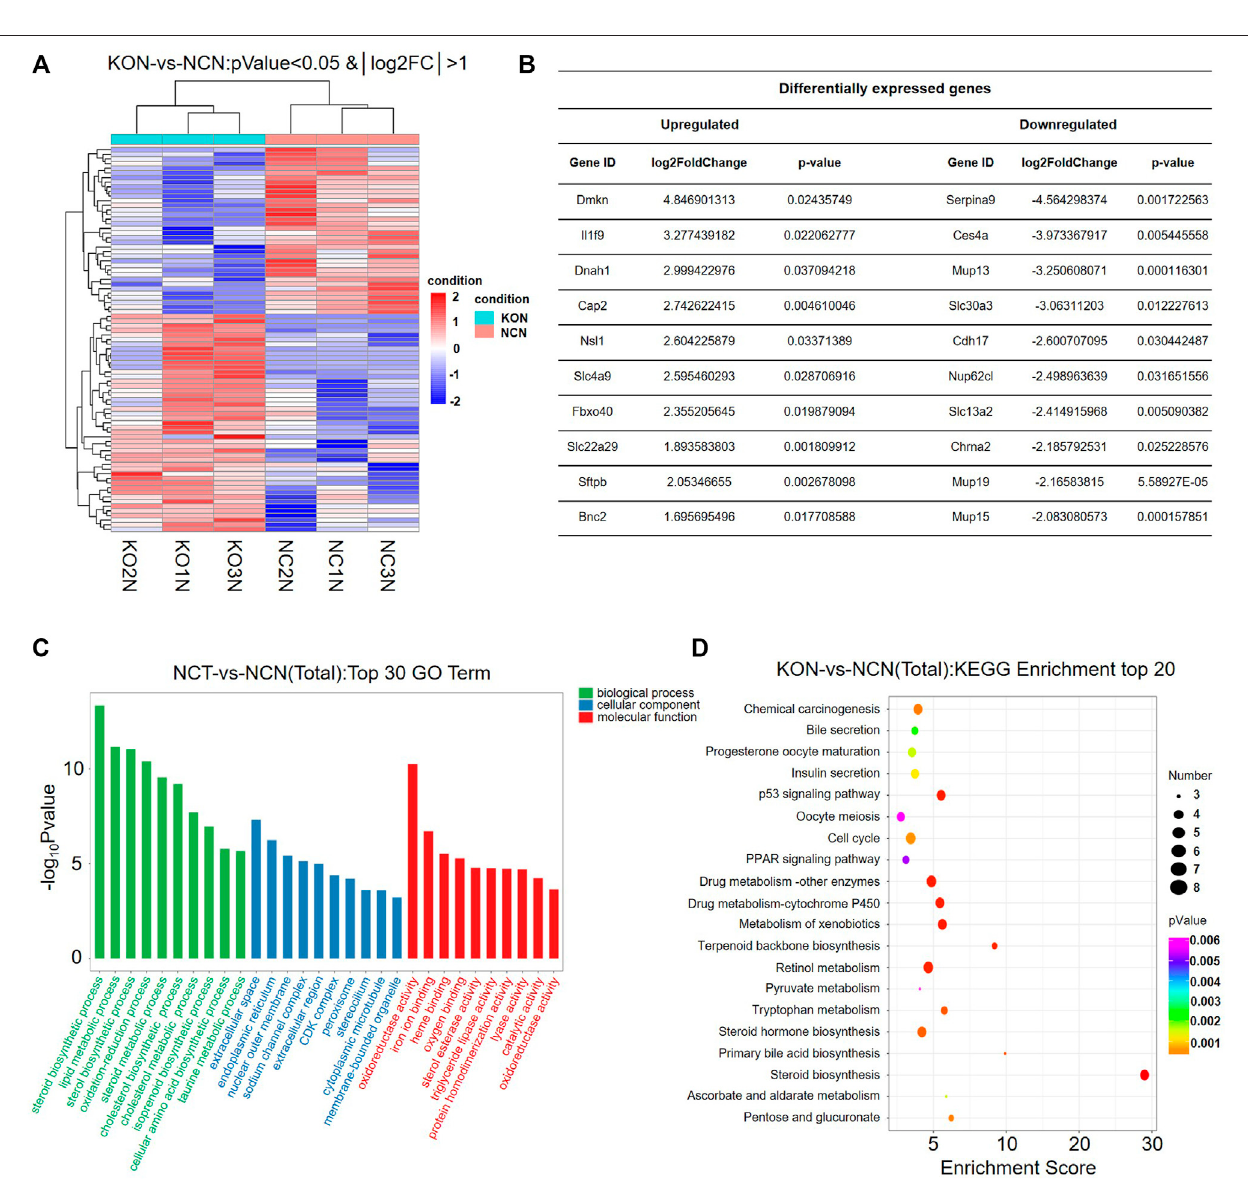
FIGURE 4 | Lipid metabolism pathway is signi fi cantly altered in N fi b − / − liver. (A) Heatmap diagrams showed the relative expression levels of total DEGs among the KON vs. NCN group, deep red = upregulated expression; white = no difference in expression; deep blue = downregulated expression. (B) Table of DEGs (upregulated and downregulated) in the top 10. (C) GO analysis of DEGs between KON and NCN in three main categories. The DEGs are dramatically enriched in lipid metabolism pathway. (D) KEGG pathway enrichment analysis of the annotated DEGs.